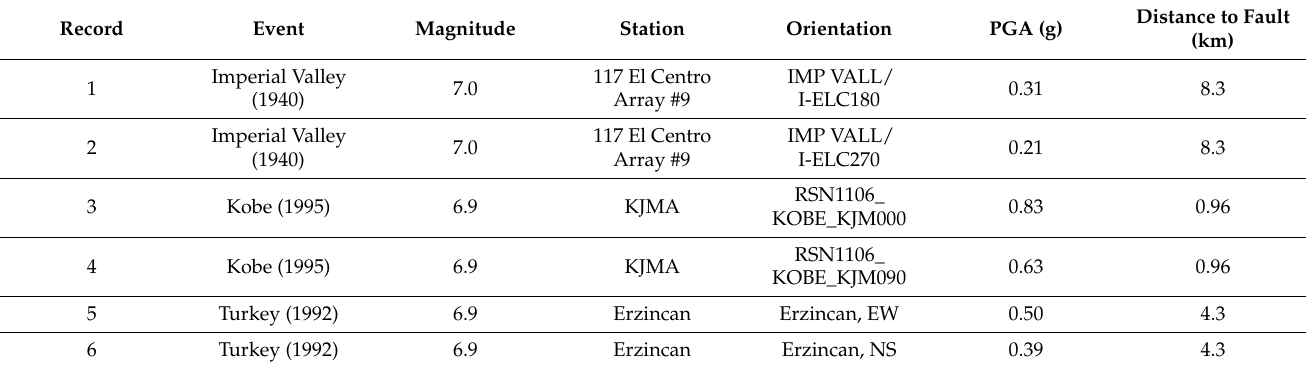
Table 2. Earthquake-recorded motions